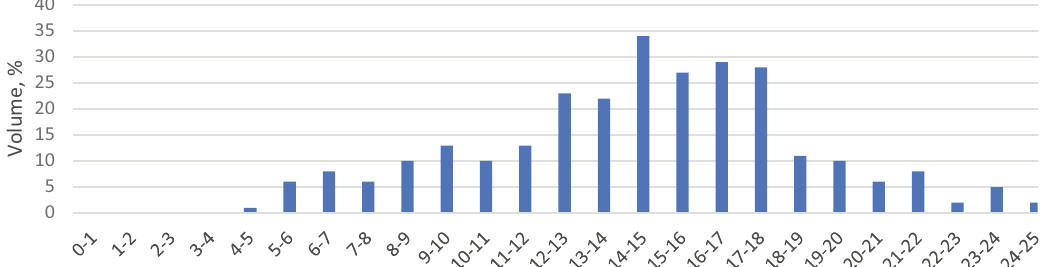
Figure 6: Distribution of particle size in the microcapsules PLA/CA.